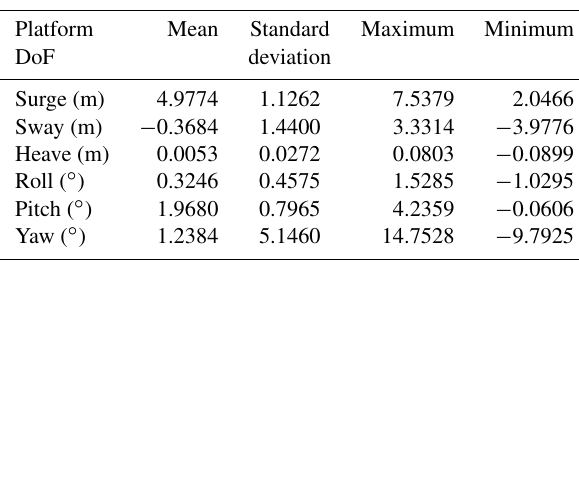
Table 1. Platform DoF statistical values for a turbulent mean wind speed of 20ms − 1 with